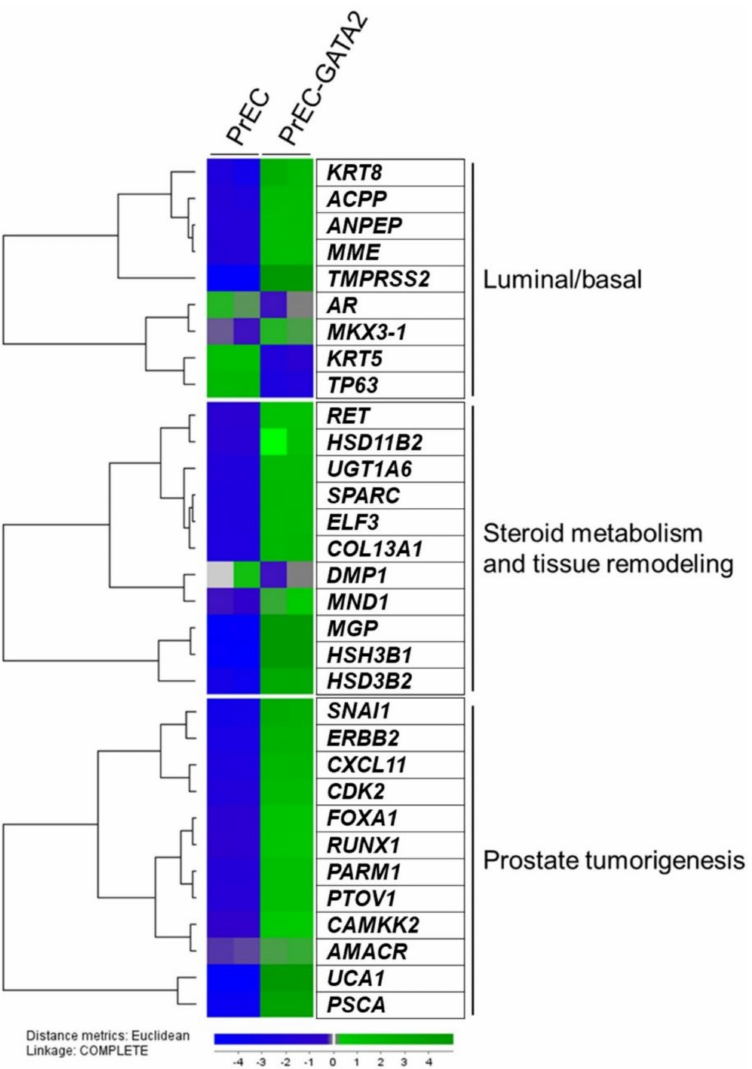
Figure 4. Agilent whole-genome microarray gene expression data. Heat map of selected genes expressed by PrEC transduced with GATA-2 wt. Genes were selected based upon GSEA and c5.all.v6.1.symbols.gmt (Broad Institute). Some presented gene sets like “androgen metabolism”